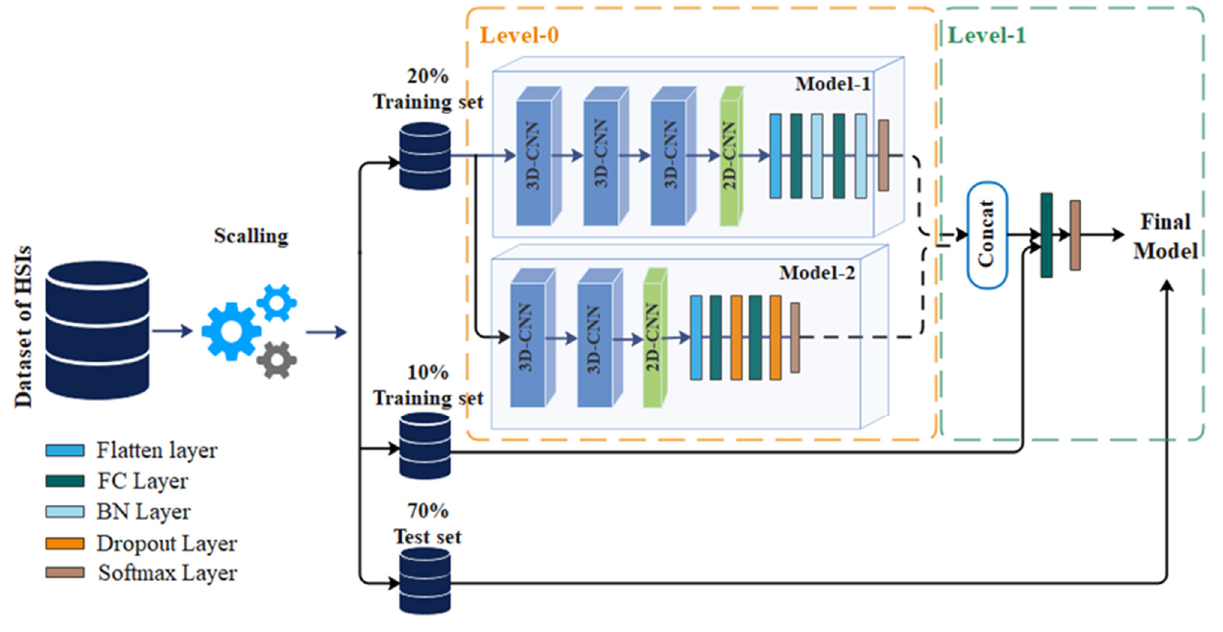
Figure 1. The framework of meta-learner hybrid models (MLHM). 2.1. Optimize the Data Distribution (QPCA, Quantile Transformation Principal Components